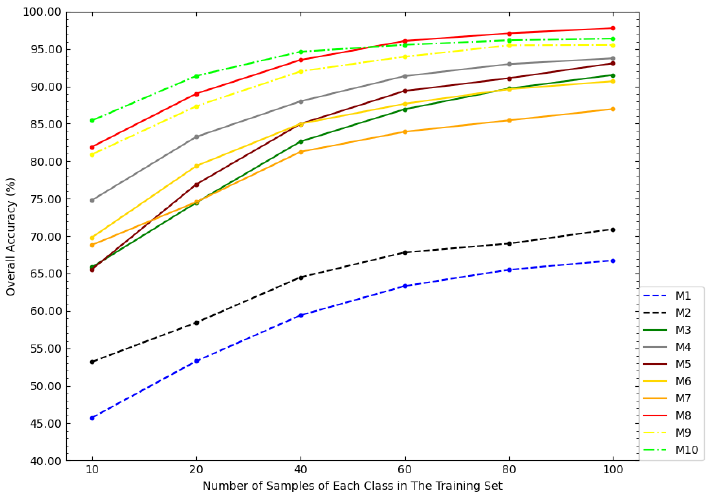
Figure 6. The OAs of each model in the Indian Pines dataset under the partitioning of training sets of different